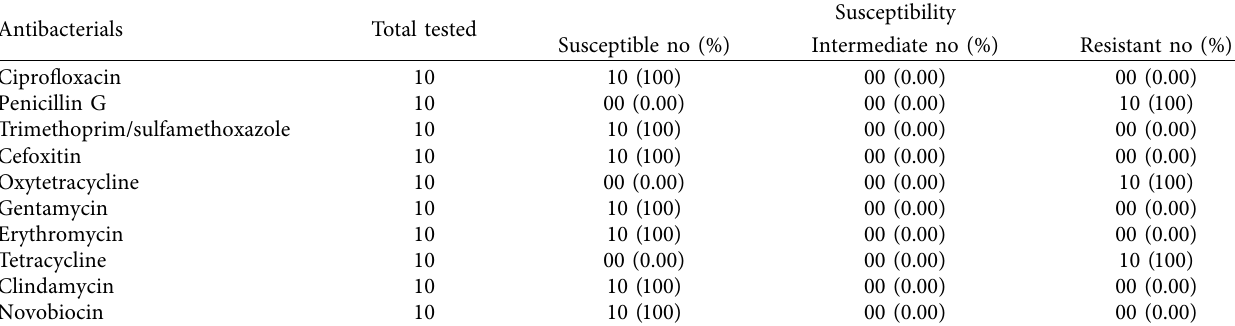
Table 4: Antibiogram characteristics of S. aureus